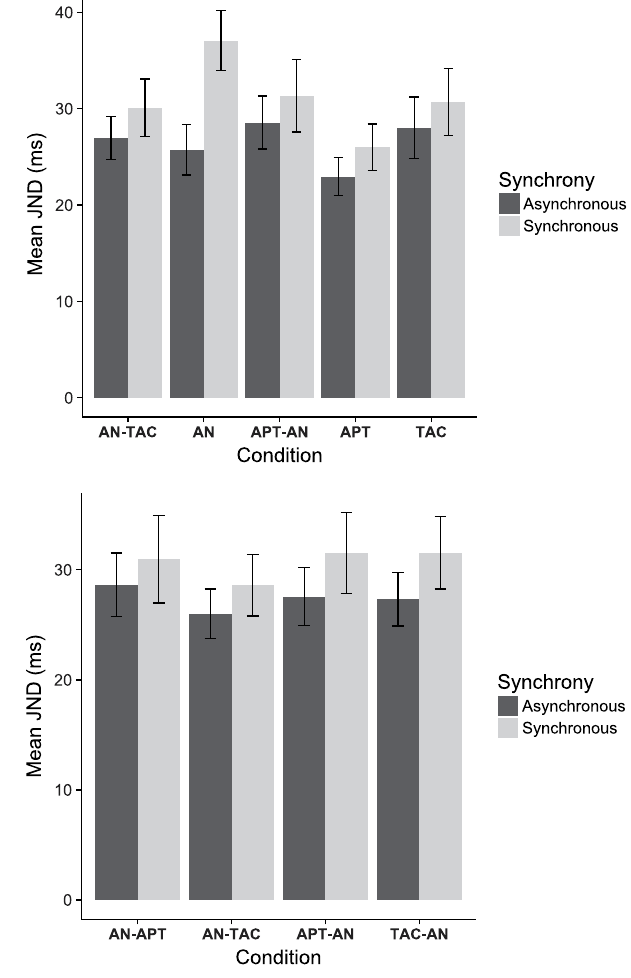
noise, APT = audio pure tone only, TAC = tactile only) and for the directional conditions (bottom panel: